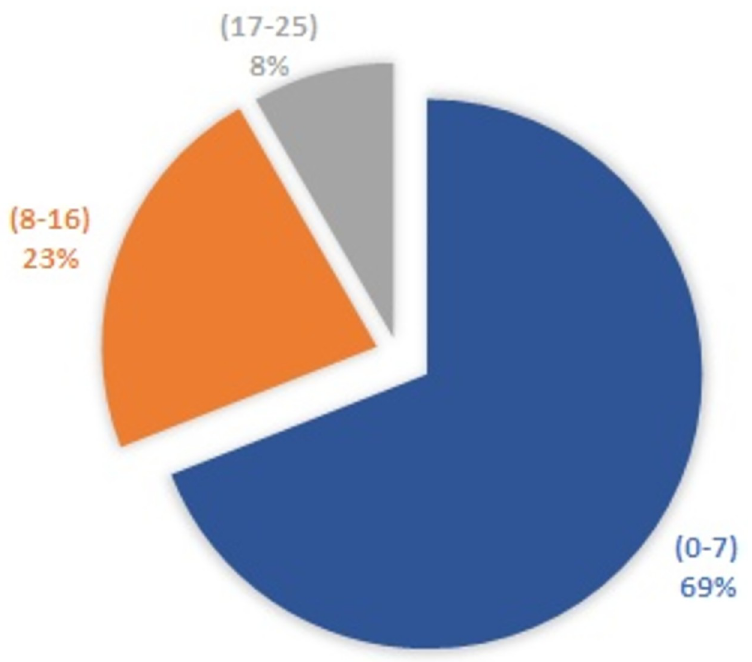
Fig 1. Classification of patients according to 25-point CT severity score. A mild grade is of 0–7 points, a moderate grade is of 8–16 points, and an advanced grade is of 17–25 points. And collectively, as the cut-off value for severe cases identification was 7, the 252 patients in this study were classified into two groups, the mild COVID-19 group (174 patients) with a CT severity score from 0 to 7 points, and the severe COVID-19 group (78 patients) which includes [(moderate grade cases (58 patients) + advanced grade (20 patients)] with a CT severity score of more than 7 points.